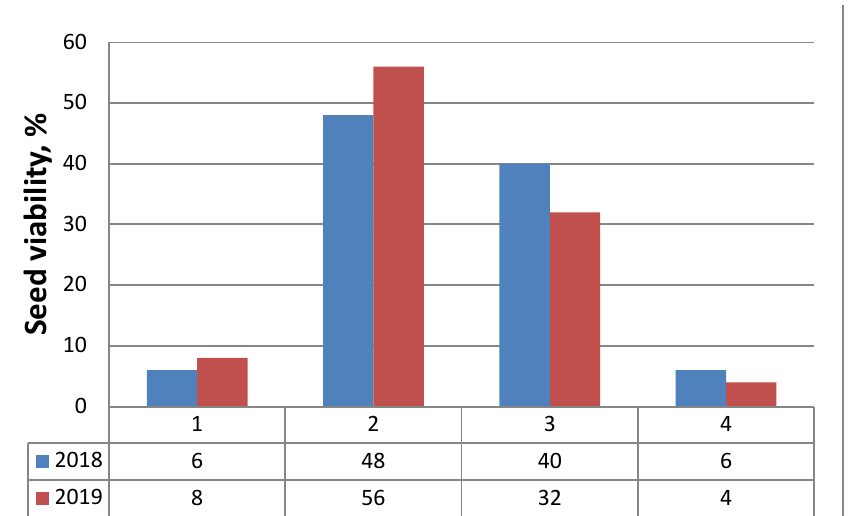
Figure 4. Frequency of seeds (embryos) viability (%) assessed by tetrazolium test in classes according to the color patterns of tested embryos for two consecutive years (2018, 2019): 1—Class I, viable embryos (stained in red); 2—Class II, viable embryos (pink colored embryos); 3—Class III, non-viable embryos (not stained); 4—Class IV, non-viable (empty)